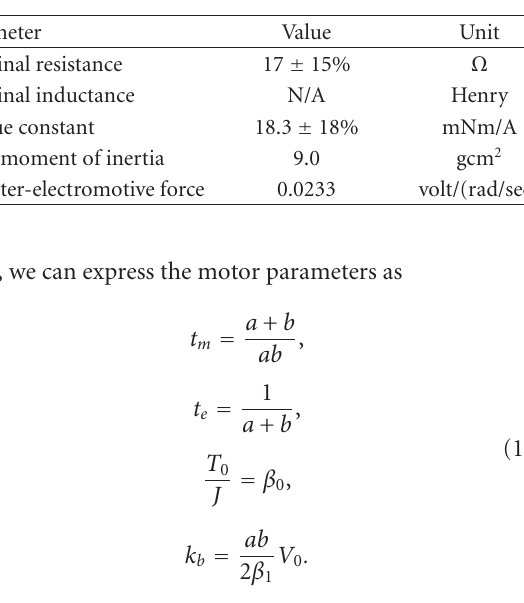
Table 1: RK370CA parameter values. Table 2: RK370CA test results.